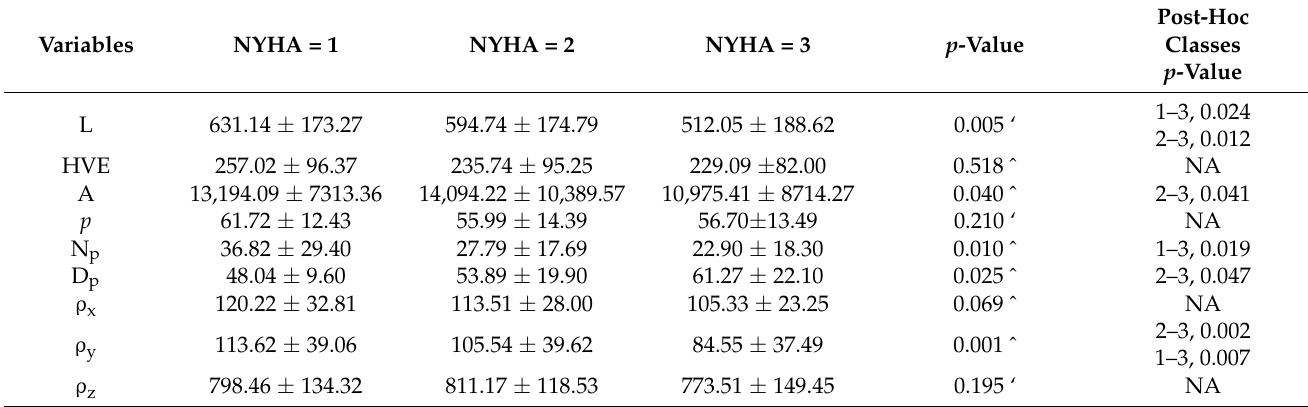
Table 2. Univariate statistical analysis performed through one-way ANOVA/Kruskal Wallis plus post-hoc tests for all the variables. Post-hoc analyses were reported only for significant tests.